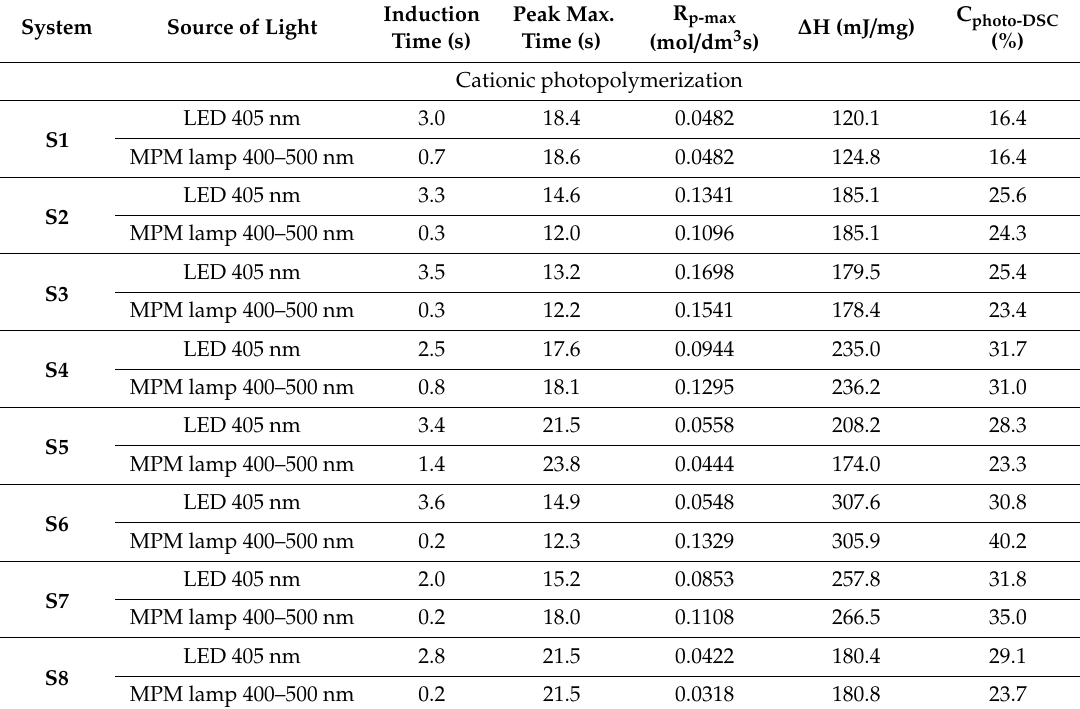
Figure 18. Profiles of TMPTA double bond conversion with HIP (1 wt.%) and 2-amino-4,6-diphenyl-pyridine-3-carbonitrile derivatives (0.1 wt.%) under 405 nm LED (intensity at the surface of sample 25 mW/cm 2 ) irradiation, calculated from photo-DSC data. The irradiation starts at t = 10 s. Table 5. Kinetic parameters obtained during cationic and free-radical photopolymerization processes using bimolecular photoinitiating systems based on 2-amino-4,6-diphenyl-pyridine-3-carbonitrile derivatives (0.1 wt.%) with diphenyliodonium salts (HIP, 1 wt.%).